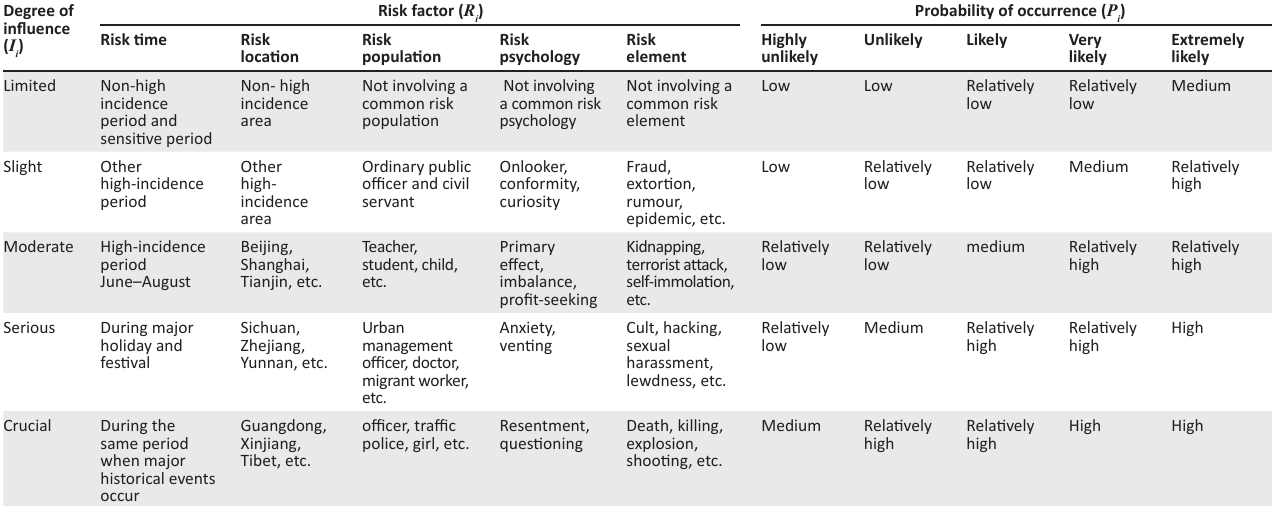
TABLE 4: Risk matrix of emergencies. Degree of influence